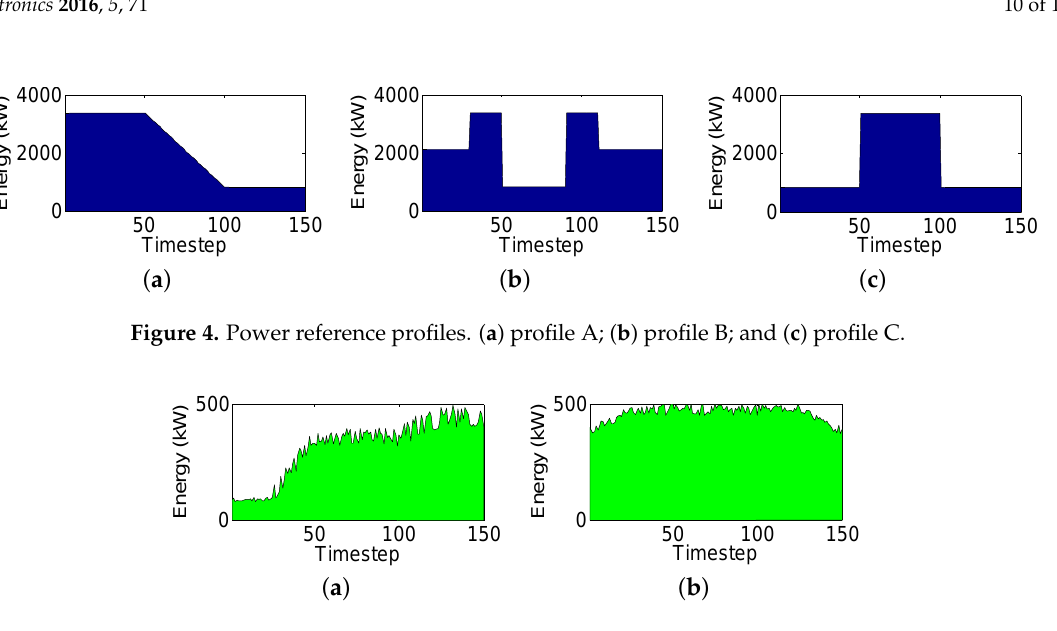
Figure 5. Green power generation profiles. ( a ) morning profile ( g 1 ); and ( b ) midday profile ( g 2 ).